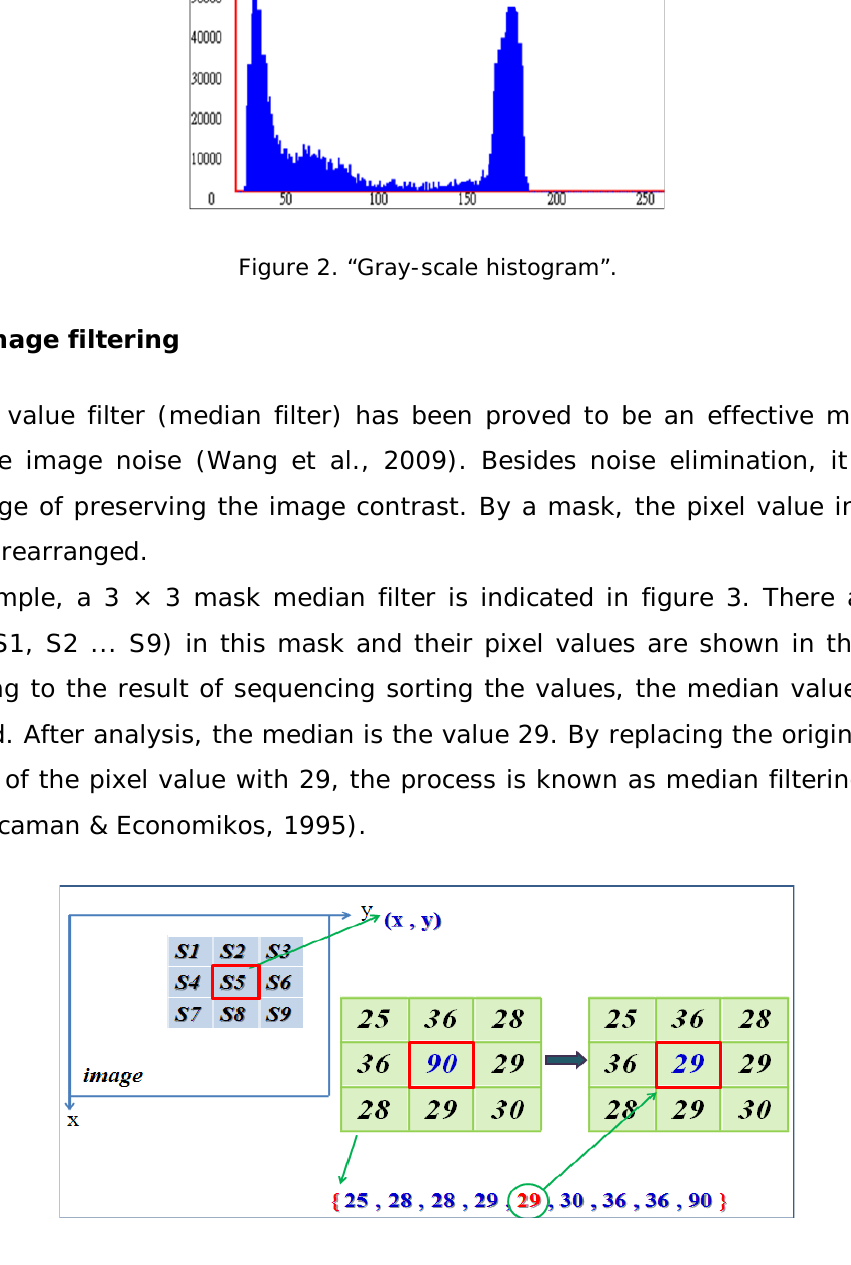
Figure 3. “Median filter